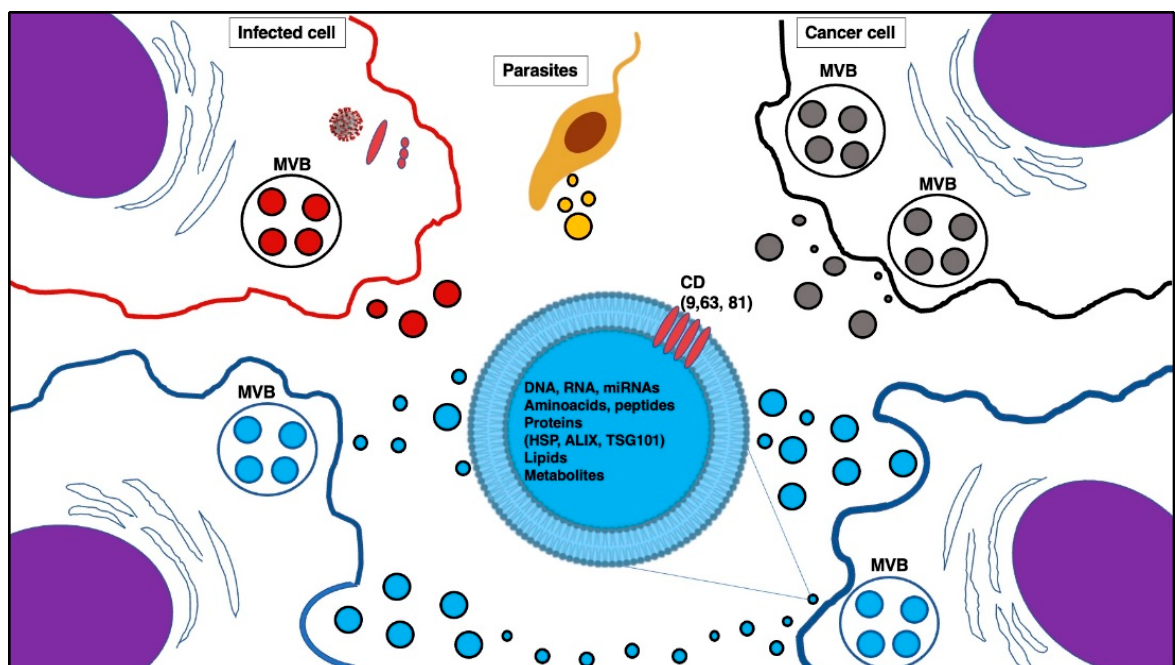
Figure 1. Exosome cross-talking. The biogenesis of exosomes begins with endocytosis to form early endosomes by inward budding, then form late endosomes, and ultimately produce multivesicular bodies (MVBs). MVBs merge with the cell membrane and, by exocytosis, release exosomes into the extracellular environment [1]. Exosomes modulate the recipient cell’s gene expression by initiating cell signaling as well as intercellular transfer of the protein, lipid, and RNA cargo, not only in a functional setting (blue exosomes in the picture) but also in cancer (gray exosomes), infectious (red exosomes), and parasitic (yellow exosomes) diseases, gaining clinical significance because of their potential use as biomarkers or next-generation therapeutics [11]. Abbreviations in the picture: MVB, multivesicular bodies; HSP, heat shock protein; ALIX, ALG-2-interacting protein X; TSG101, tumor susceptibility gene 101; CD, cluster of